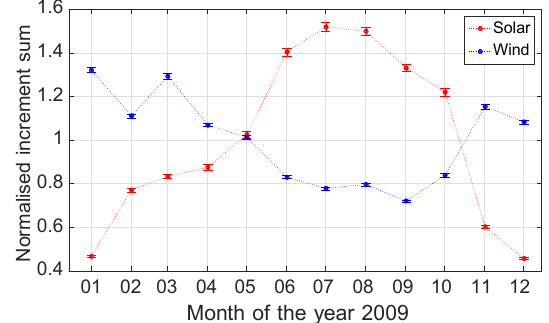
Figure 7. Monthly mean of the 10min spatial mesoscale wind and solar variability. The errorbars show the standard error.